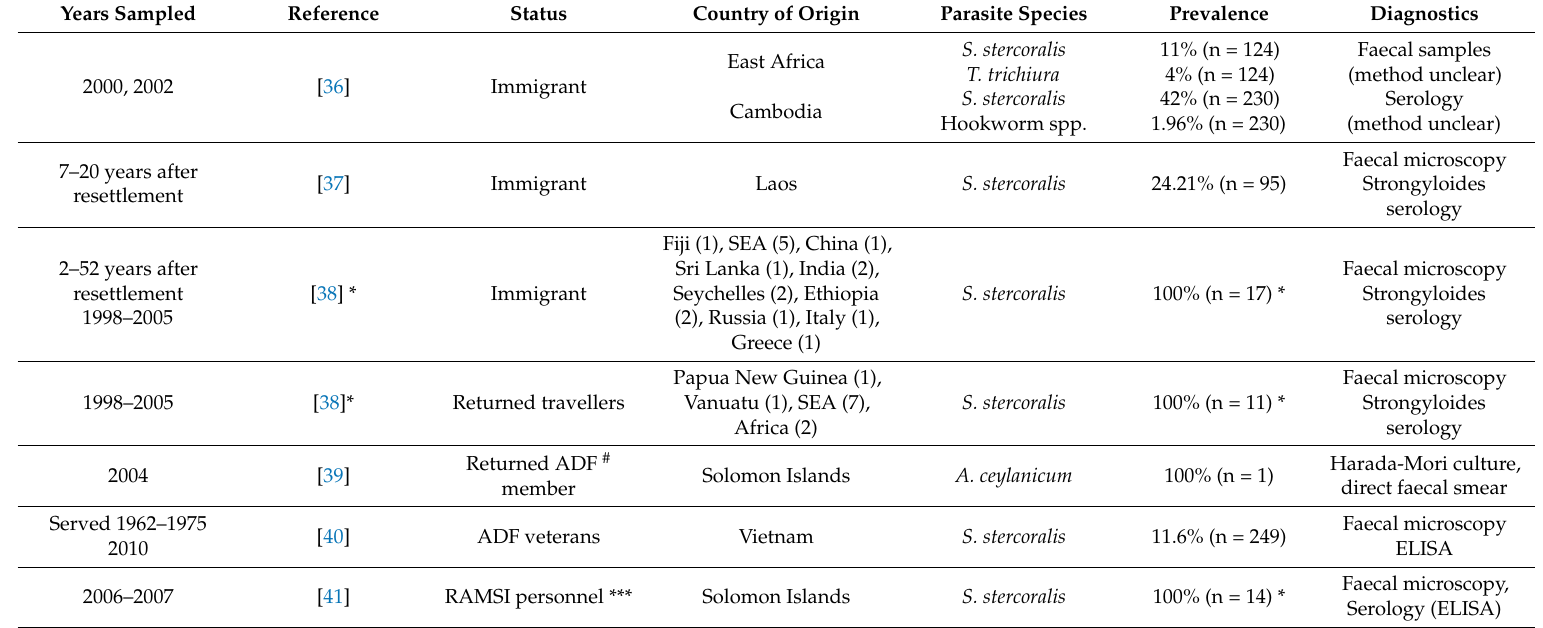
Table 1. Prevalence of soil-transmitted helminths diagnosed in immigrants, refugees, ADF # personnel, and returned travellers in Australia since